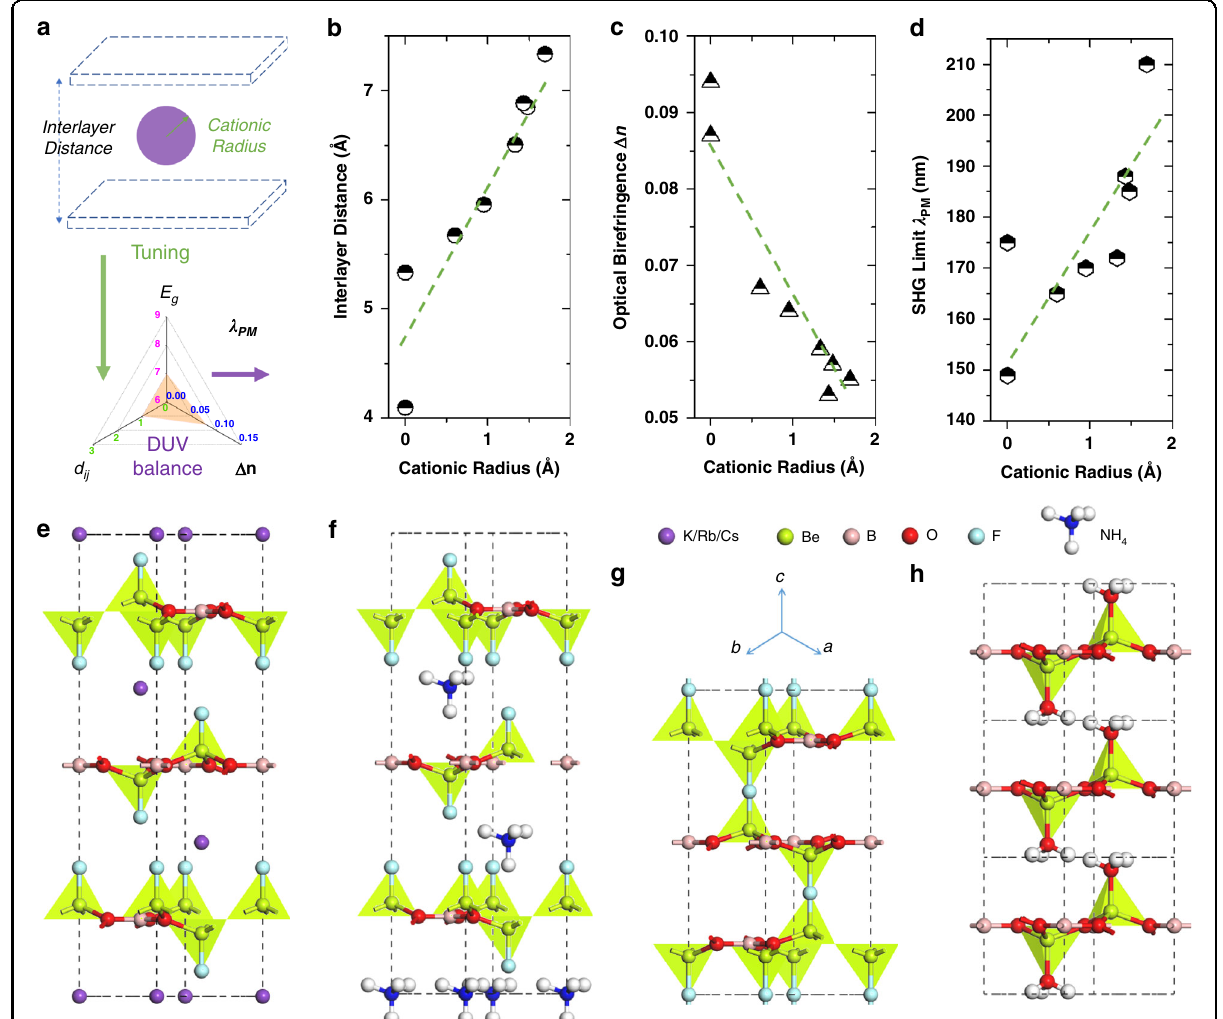
Fig. 2 Interlayer cationic tuning strategy and related materials. Schematic diagram of tuning the DUV balance with A-site cationic size ( a ), and the theoretical data of effective interlayer distance ( b ), Δ n ( c ), and λ PM ( d ) varying from the A-site cationic radius in the KBBF-type structures; structural evolution from KBBF with K + ( e ) to NH 4 Be 2 BO 3 F 2 (ABBF) with NH 4 + ( f ), F-bridged γ -Be 2 BO 3 F (BBF) ( g ) and vdW Be 2 BO 5 H 3 (BBH) without the A-site cations ( h